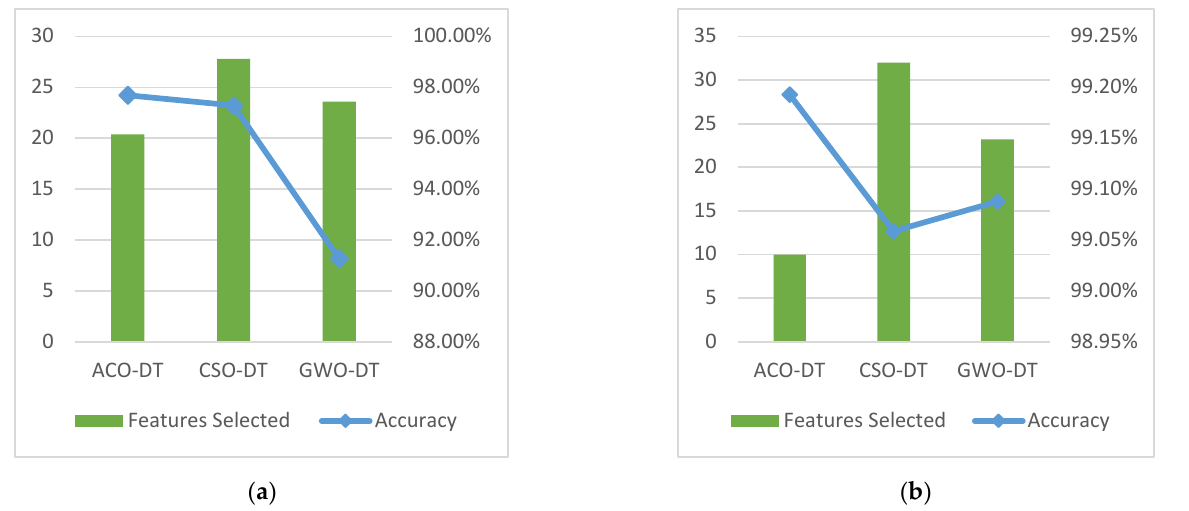
Figure 4. ( a ) Features selected vs. accuracy with the ClaMP dataset. ( b ) Features selected vs. Accuracy